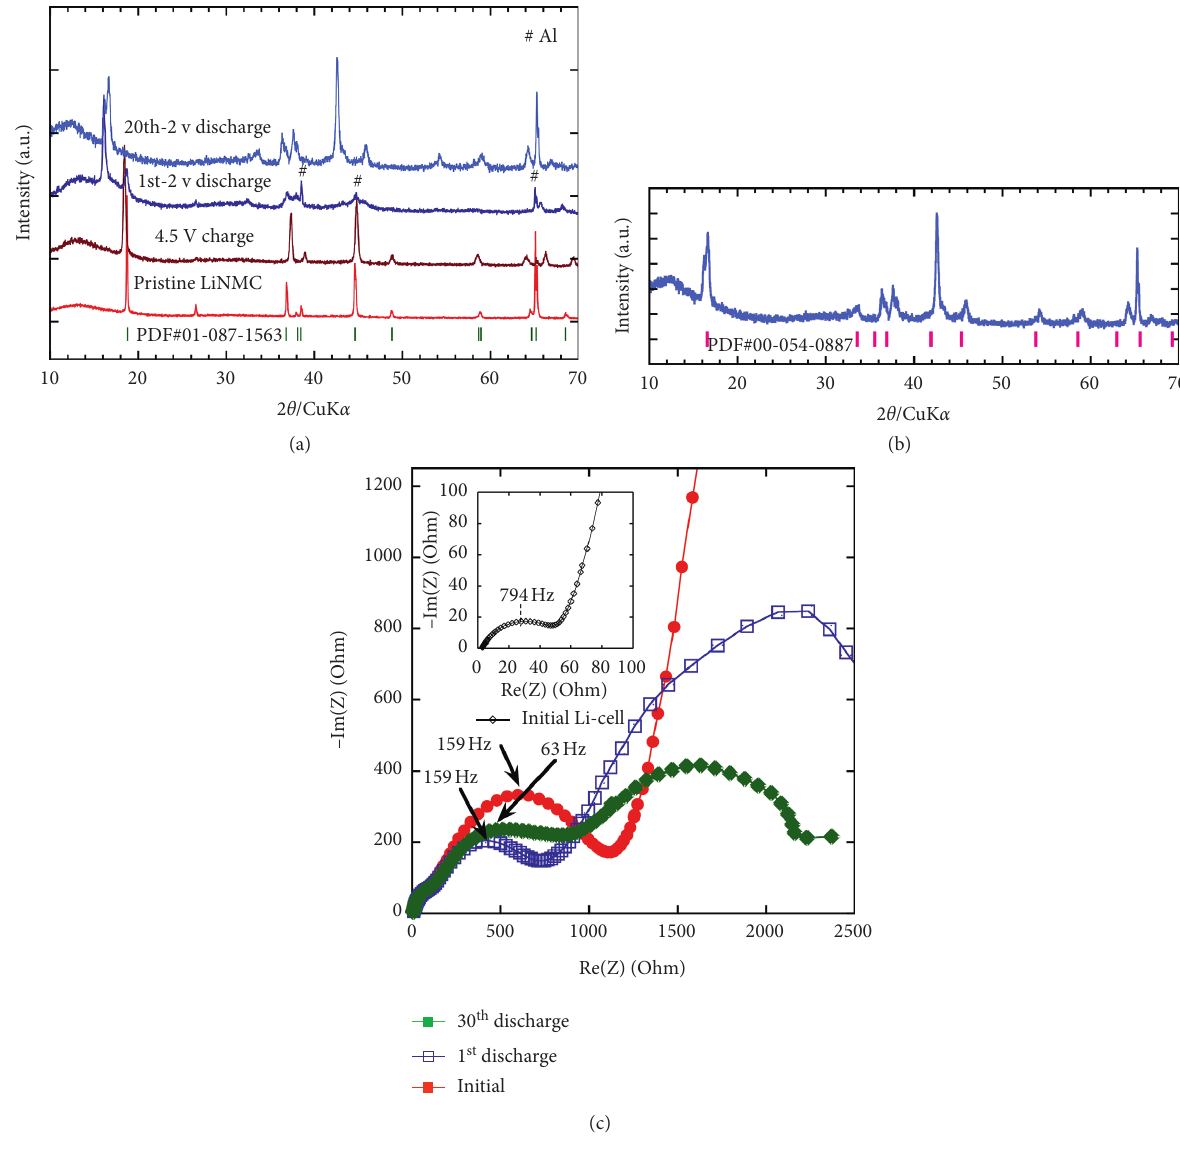
Figure 4: (a) XRD of pristine LiNMC, 2 nd discharge, and 20 th discharge of new sodium cathode; (b) XRD of the new sodium cathode at the 20 th discharge; and (c) EIS spectra of the LiNMC cathode in Li-cell and the new sodium cathode at various stages in